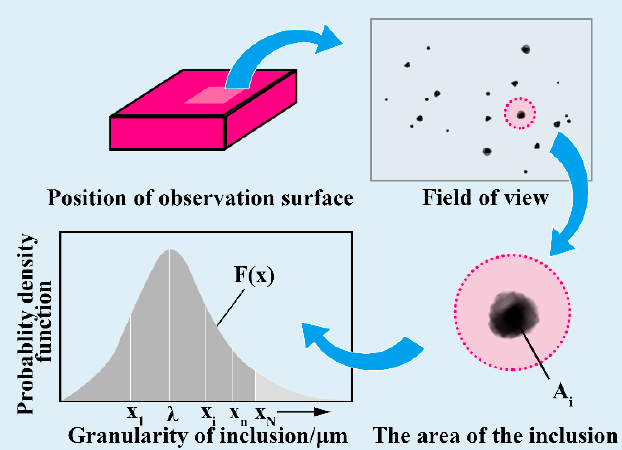
Figure 12. Schematic diagram of data fitting and sampling observation by LEVD.